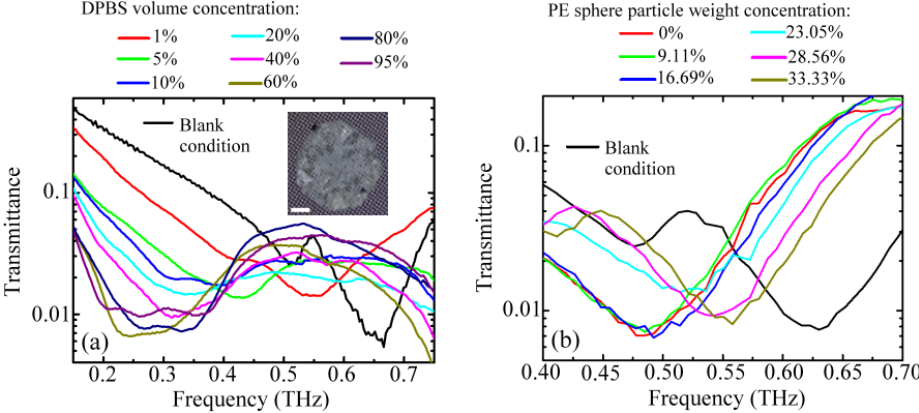
Figure 8. Measured transmission spectral curves of 90 μ m W MCWM for sensing various amounts of ( a ) salt grains and ( b ) PE sphere particles. ( a ) salt grains and ( b ) PE sphere